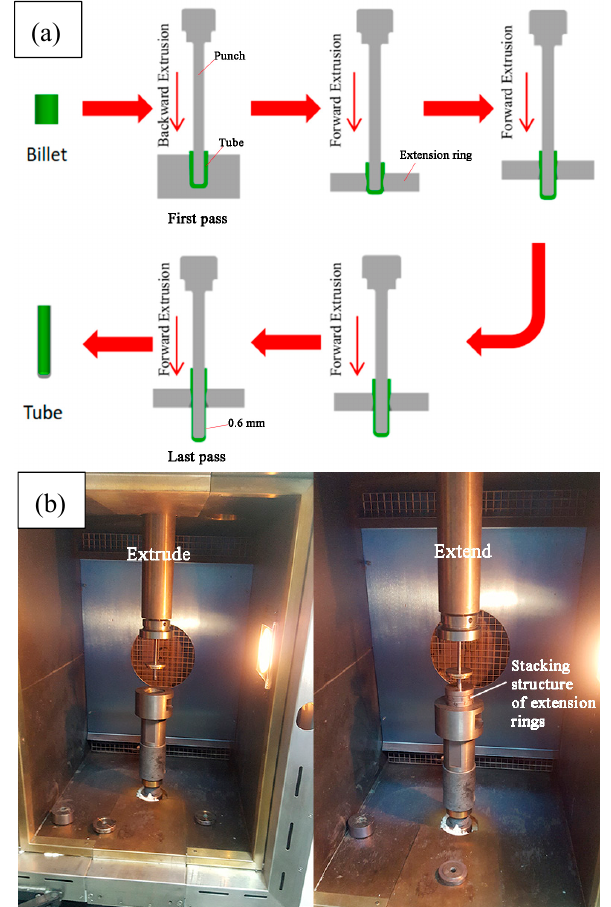
Figure 2. Forming process of magnesium alloy thin-walled tubes: ( a ) extension, one by one after backward extrusion; ( b ) stacking structure of extension rings after backward extrusion.